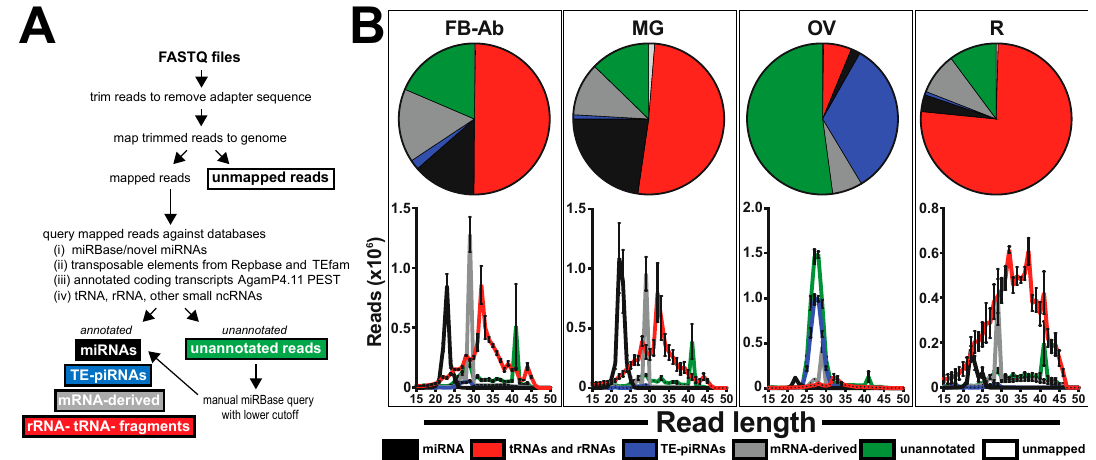
Figure 1. Diversity of small ncRNA groups across mosquito tissues. ( A ) Flow chart for the small ncRNA query against various databases. ( B ) Female mosquito tissues analyzed were (i) fat body-abdominal wall (FB-Ab), (ii) midgut (MG), (iii) ovary (OV), and (iv) the remaining tissues comprised of the head and thorax (R). Annotated small ncRNA groups include (i) miRNAs, (ii) tRNA/rRNA, (iii) TE-piRNAs, (iv) mRNA-derived small ncRNAs, (v) unannotated, and (vi) unmapped. For each mosquito tissue group, data demonstrate the read annotation percentages and the corresponding histograms of the nt size representing the various small ncRNA groups. All values graphed as average +/ − SEM from three biological replicates.